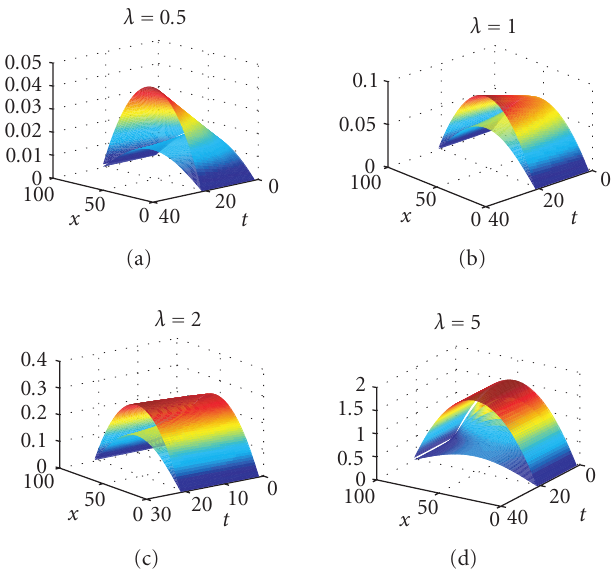
Figure 4.1. Upper and lower bounds for the slab geometry, when β = 0 . 5, δ = 0 . 1, and λ = 0 . 5,1,2,5.